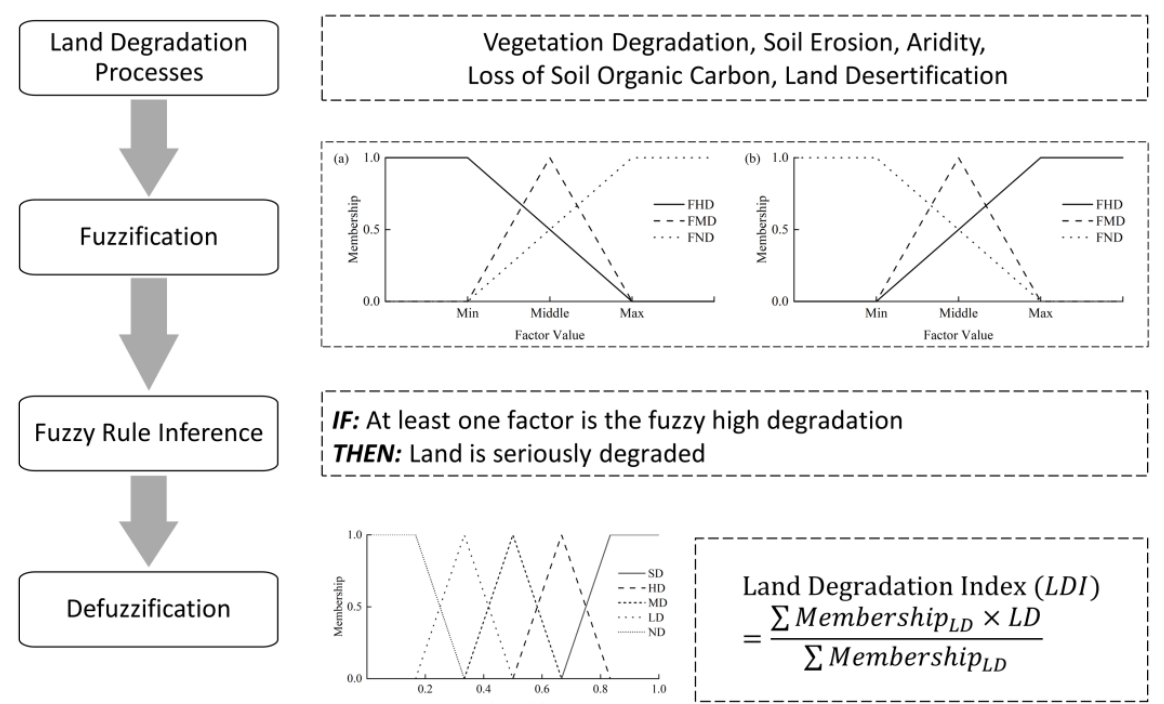
Figure 2. Flowchart of land degradation assessment based on the fuzzy logic modeling method. ( a ) The membership of vegetation degradation, aridity and loss of soil organic carbon. ( b ) The membership of soil erosion and desertification.